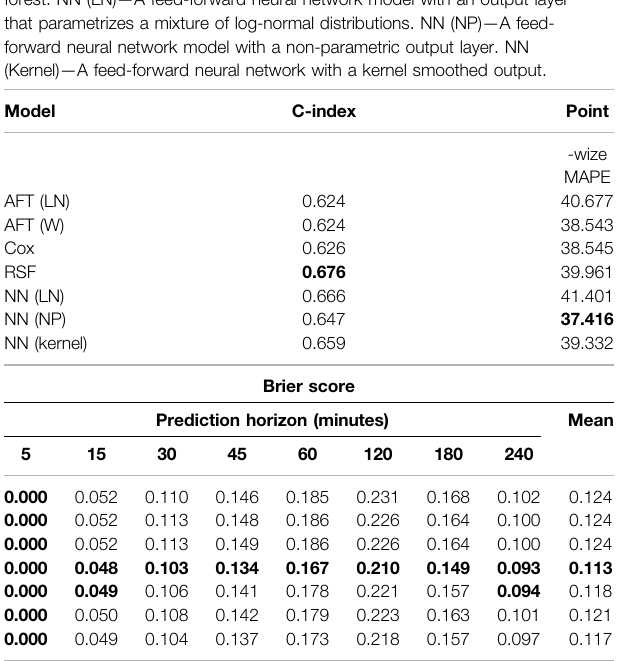
TABLE 2 | Performance measures for models in a static setting, where we make only a single prediction per incident using a set of time-invariant covariates. Optimal values are highlighted in bold. AFT (LN) — An accelerated failure time model assuming a log-normal distribution of incident durations. AFT (W) —